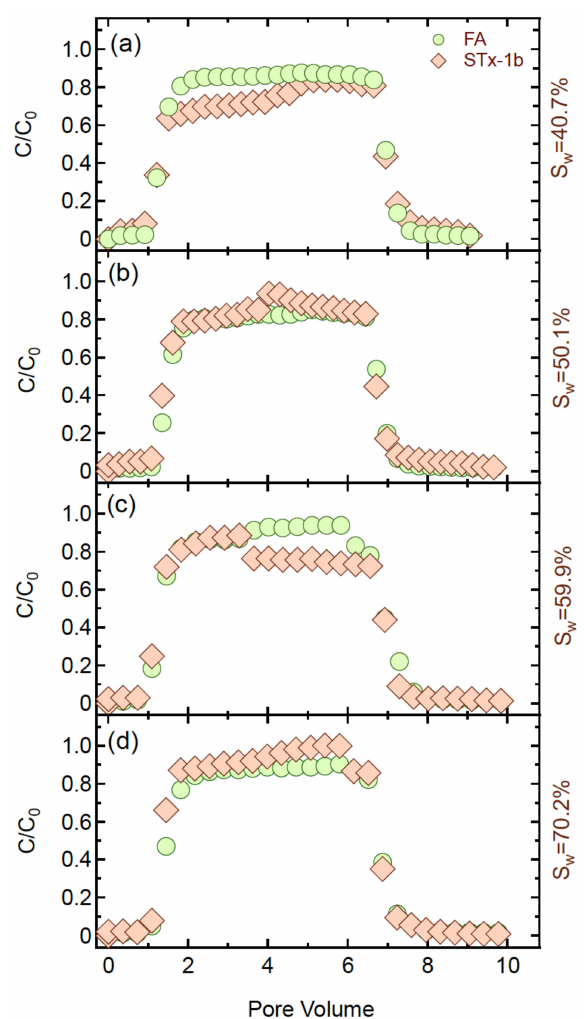
Figure 4. Breakthrough data from the co-transport experiments with FA and montmorillonite particles in unsaturated columns packed with sand under various flow rates: ( a ) 1, ( b ) 1.5, ( c ) 2, and ( d ) 3 mL /